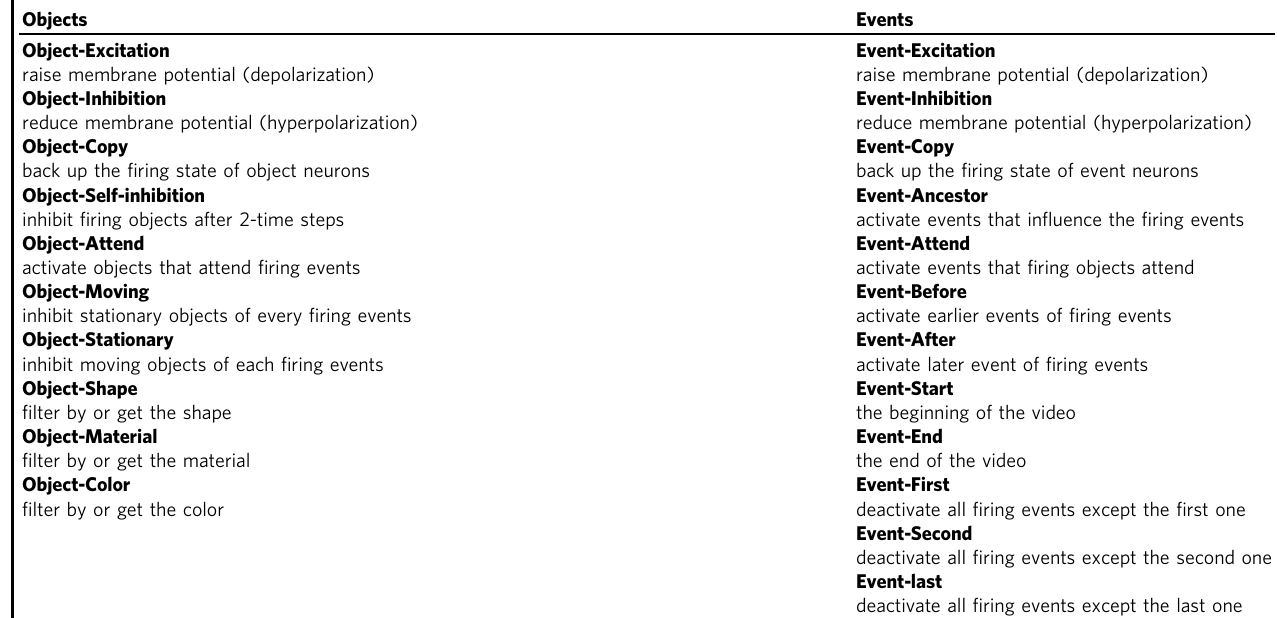
Table 2 Basic operations supported by